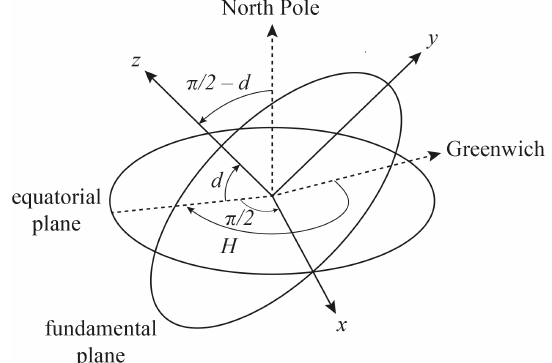
Figure A1. Transformation of the Earth-fixed coordinates to coor- dinates in the fundamental reference frame. Take the Earth-fixed x axis pointed at Greenwich and rotate it around the z axis (toward the North Pole) to − (H − π/ 2 ) . Then, rotate around the new x axis by π/ 2 − d to make the new z axis parallel to the shadow axis (see Fig.